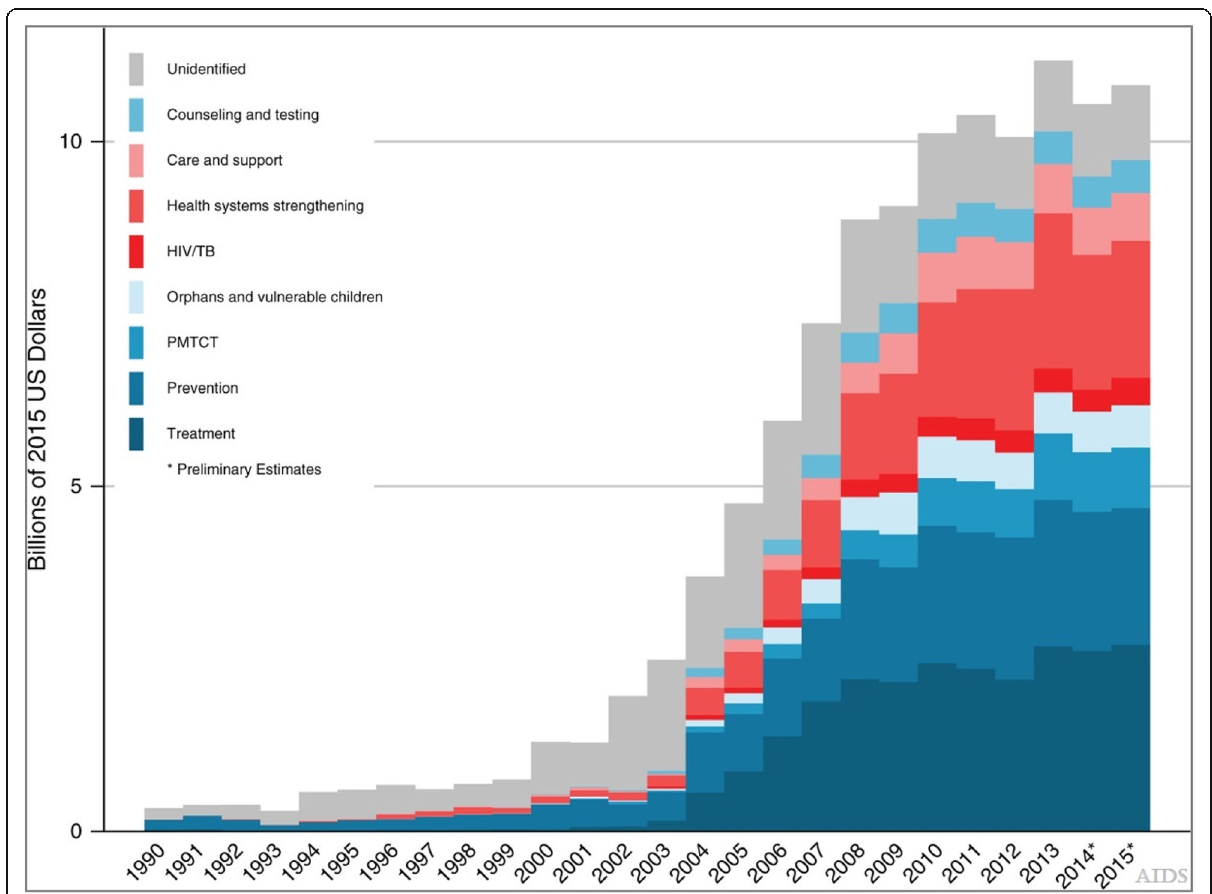
Fig. 1 Tracking development assistance for HIV/AIDS: the international response to a global